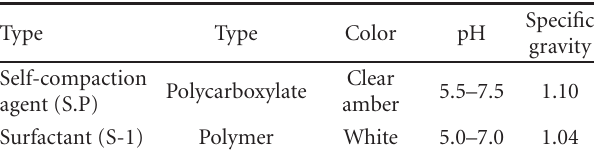
Table 3: Properties of